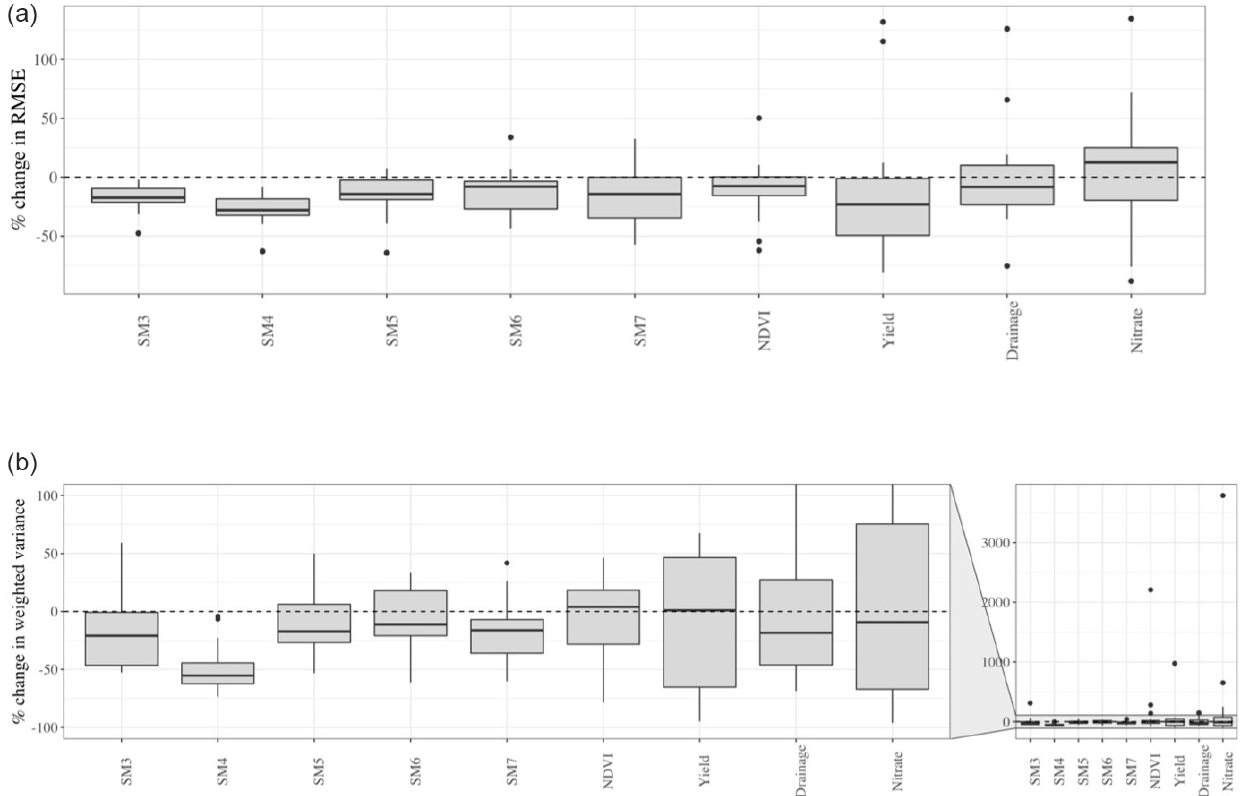
Figure 4. Boxplots demonstrating the distribution of relative change in (a) accuracy (RMSE) and (b) precision (weighted variance) due to in situ SDA for each state variable across all site years. The relative change is computed with respect to the free model run, with negative values indicating SDA